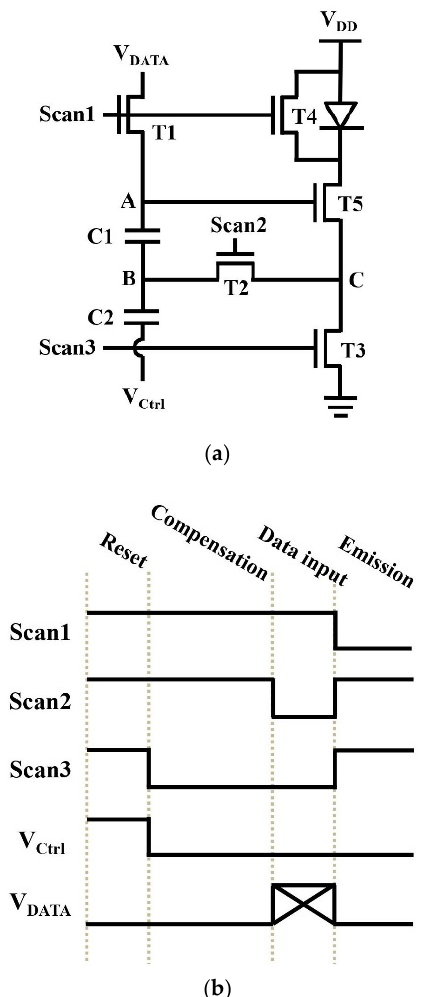
Figure 2. Proposed pixel circuit. ( a ) Circuit schematic. ( b ) Timing diagram.